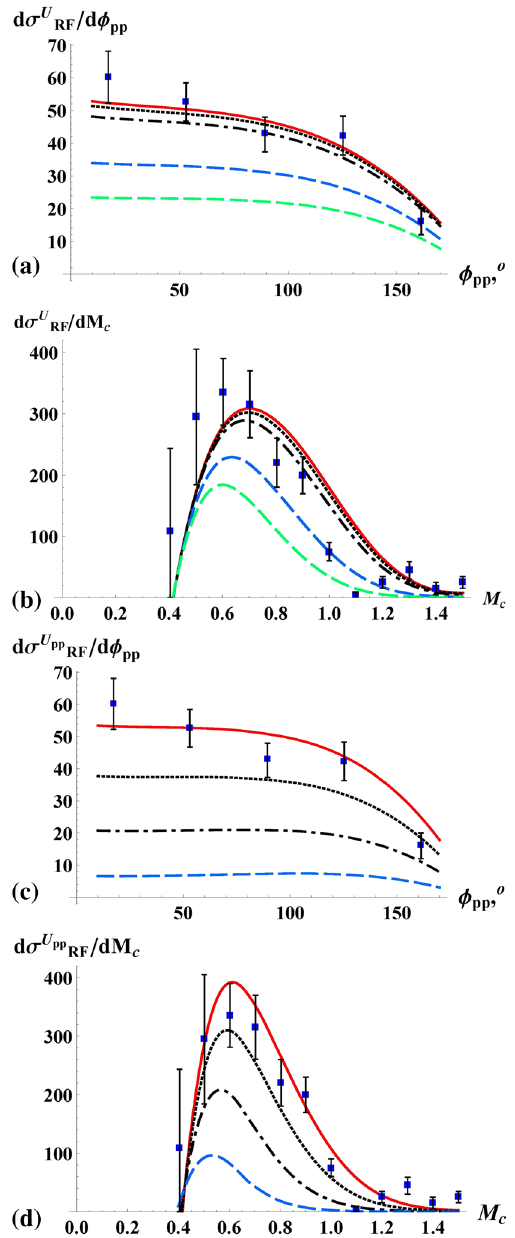
Fig. 5 RF case of the model (see Fig. 3). The data on the process p + √ p → p + π + + π − + p at s = 200 GeV, | η π | < 1, | η ππ | < 2, p T π > 0 . 15 GeV, 0 . 005 < − t 1 , 2 < 0 . 03 GeV 2 , (STAR collaboration [17, 18]). a , b The result with all p p and π p rescattering corrections, c , d show the result, when we try to fit the data by formulas without π p rescattering terms. Curves from up to down correspond to different values of the parameter Λ π in the off-shell pion form factor (11): (a),(b) Λ π = 5 , 4 , 3 , 1 . 6 , 1 . 2 GeV, (c),(d) Λ π = 1 . 2 , 1 , 0 . 8 , 0 . 6